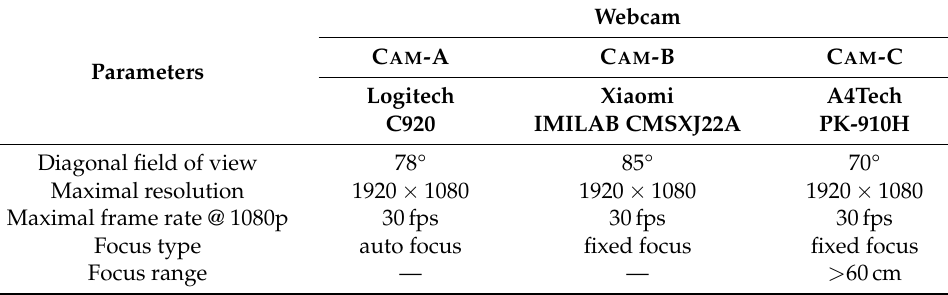
Table 2. Main technical data of the cameras used in the